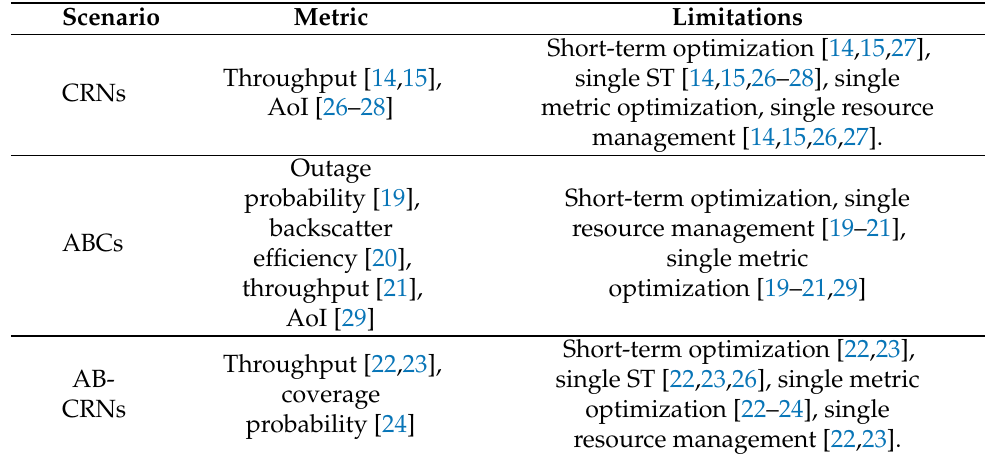
Table 1. Comparison Table of the Related